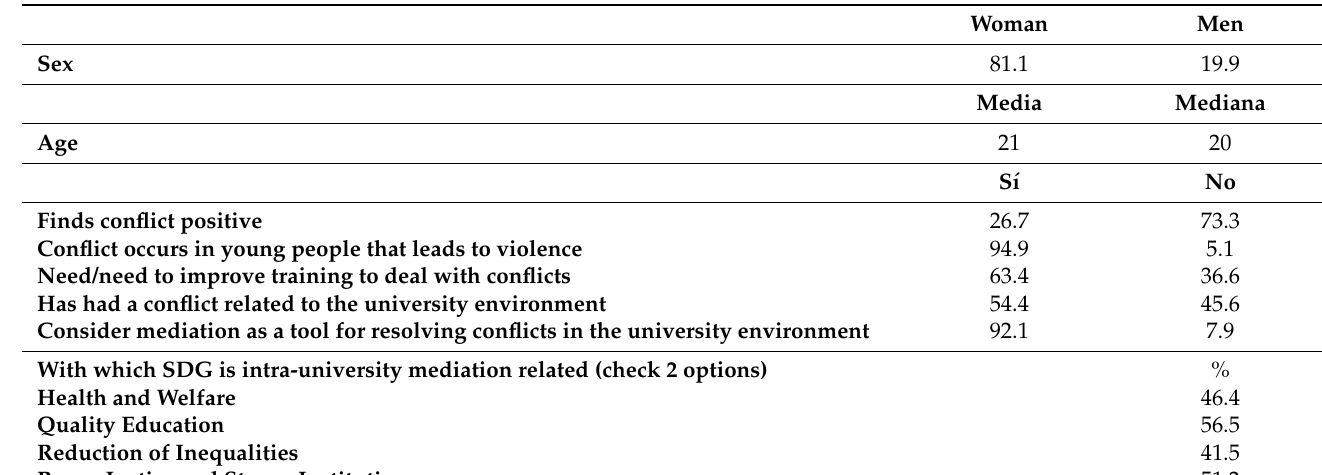
Table 2. Main descriptive results of the students and conflict assessment (in